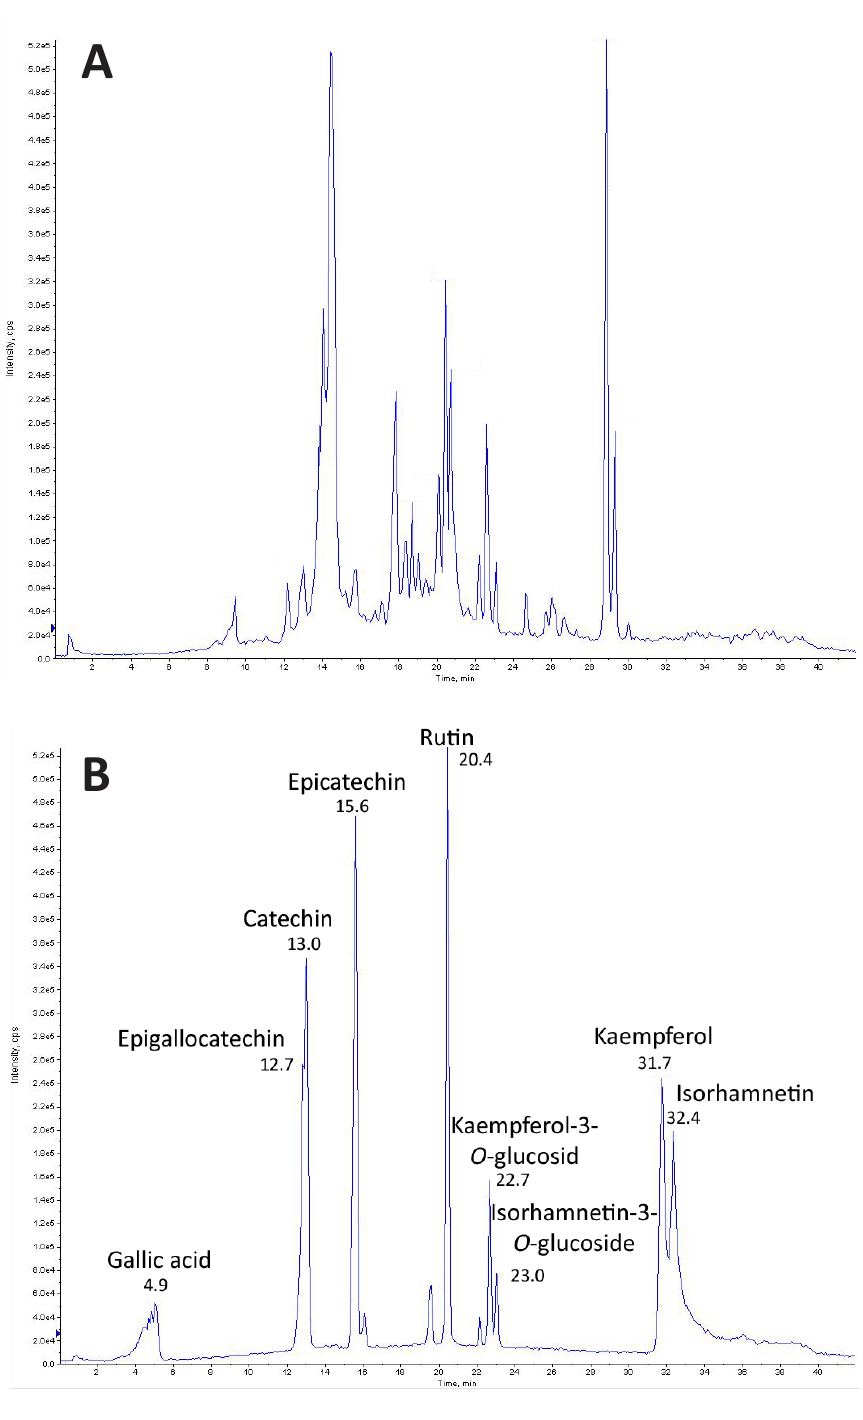
Fig. 3. MS traces based on 23 [M–H] - ions shown for A) a representative leaf sample of cv. ‘Ljubitelskaja’ (July 2) and B) for the standards that were used for identification and quantification. For the standards the retention times are also